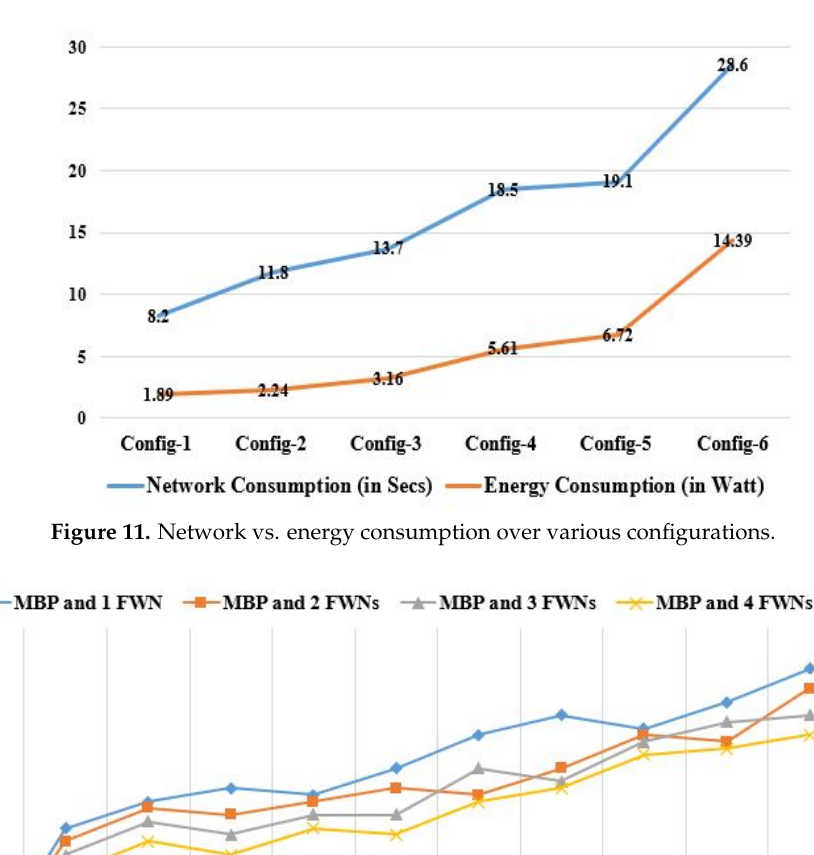
Figure 10. Throughput vs. bandwidth usage over various configurations.